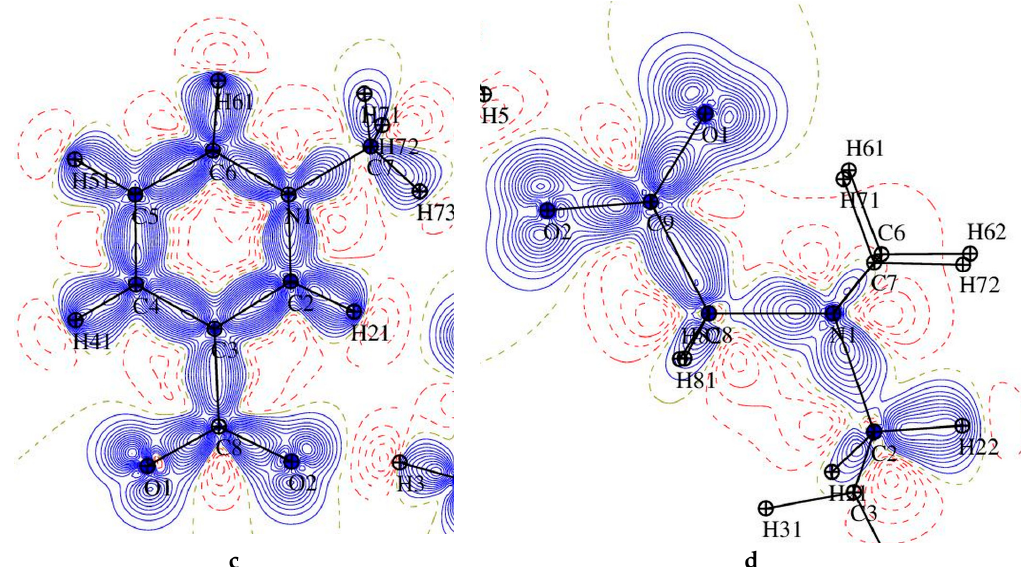
Figure 6. The static deformation electron density distribution for 1 ( left ) and 2 ( right ): hydroxybenzoic acid ( a,b ), pyridine ring ( c ) and O1-C9-O2 plane ( d ), the positive ( blue ) and negative (dashed red) contours are drawn at intervals 0.05 e Å − 3 .